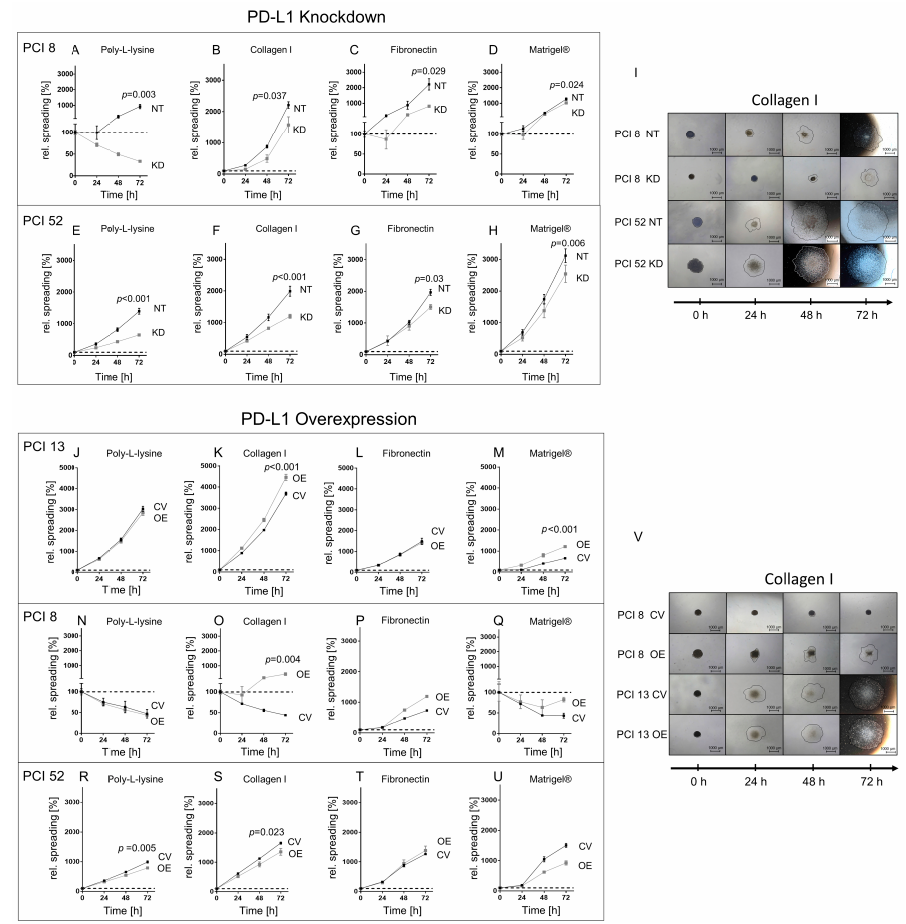
Figure 2. PD-L1-dependent cell spreading on various matrices. Spheroids from cell lines with low (PCI 13), moderate (PCI 8) and high PD-L1 expression (PCI 52) were seeded onto four di ff erently coated surfaces: collagen type I, fibronectin and Matrigel ® , a laminin-rich matrix. Poly-L-lysine served as control. Cell spreading was measured over a period of 72 h. The dotted line represents the initial area. ( A – H ) Spreading of PCI 8 and 52 spheroids after PD-L1 KD. ( I ) Exemplified images of cell spreading of NT and PD-L1 KD PCI 8 and PCI 52 spheroids on collagen type I. ( J – U ) Cell spreading of PD-L1 OE spheroids of PCI 13, PCI 8 and PCI 52. ( V ) Exemplified images of CV and PD-L1 OE PCI 8 and PCI 13 on collagen type I. Scale bar = 1000 µ M, black line depicts spreading area measured and calculated with the ImageJ software. The results are expressed as means ± SD, n = 4; endpoints after 72 h were statistically compared by unpaired Student’s t